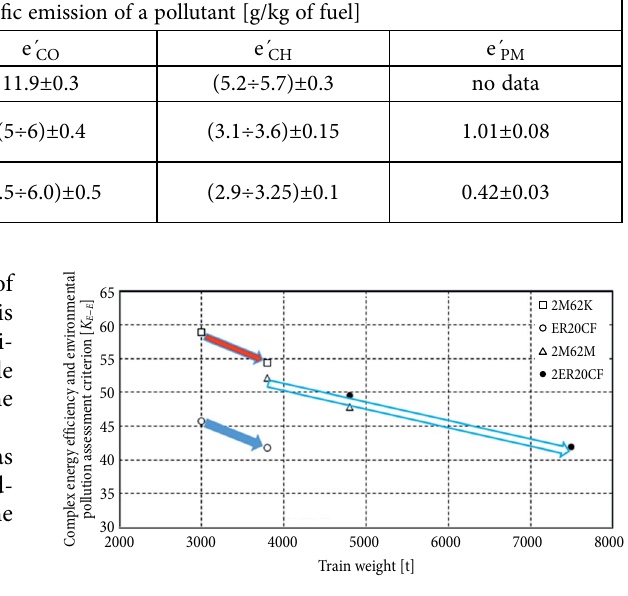
Fig. 5. Evaluation of energy efficiency on freight transportation line